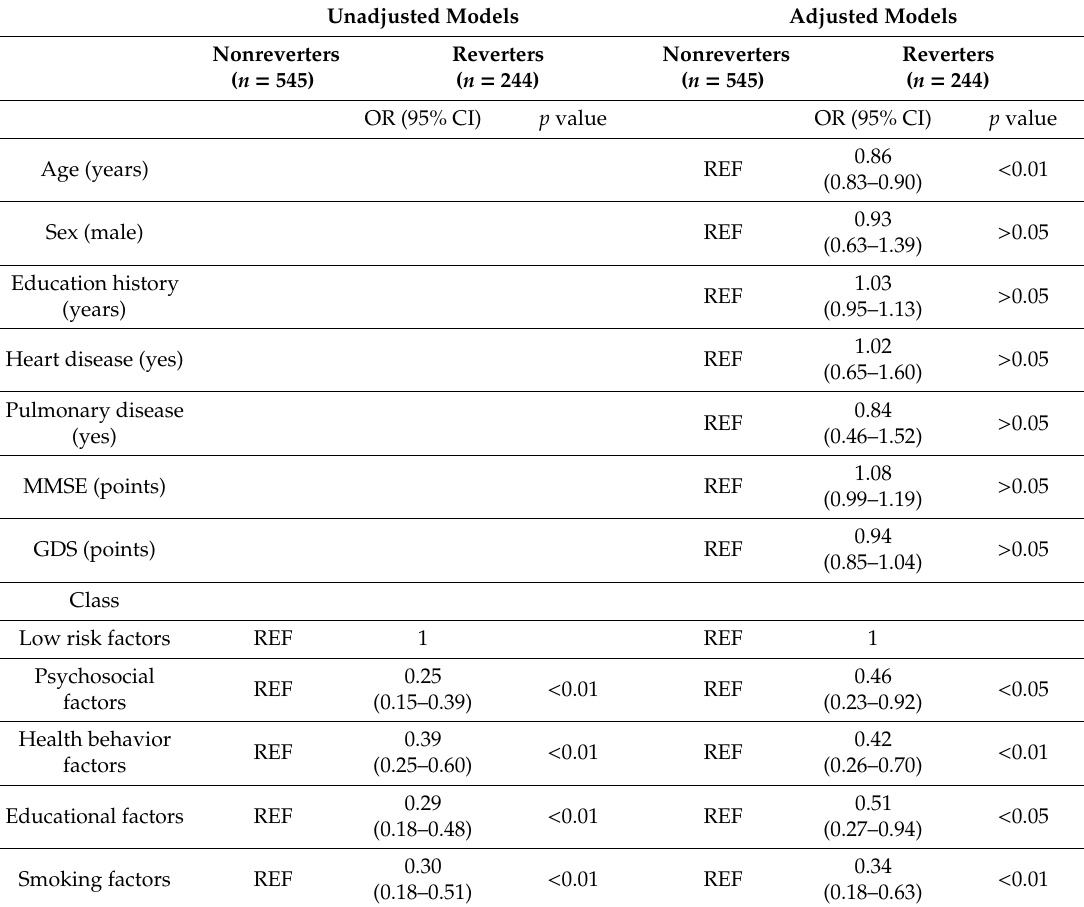
Table 5. Binomial logistic regression analysis with cluster membership as dependent variable. Unadjusted Models Adjusted